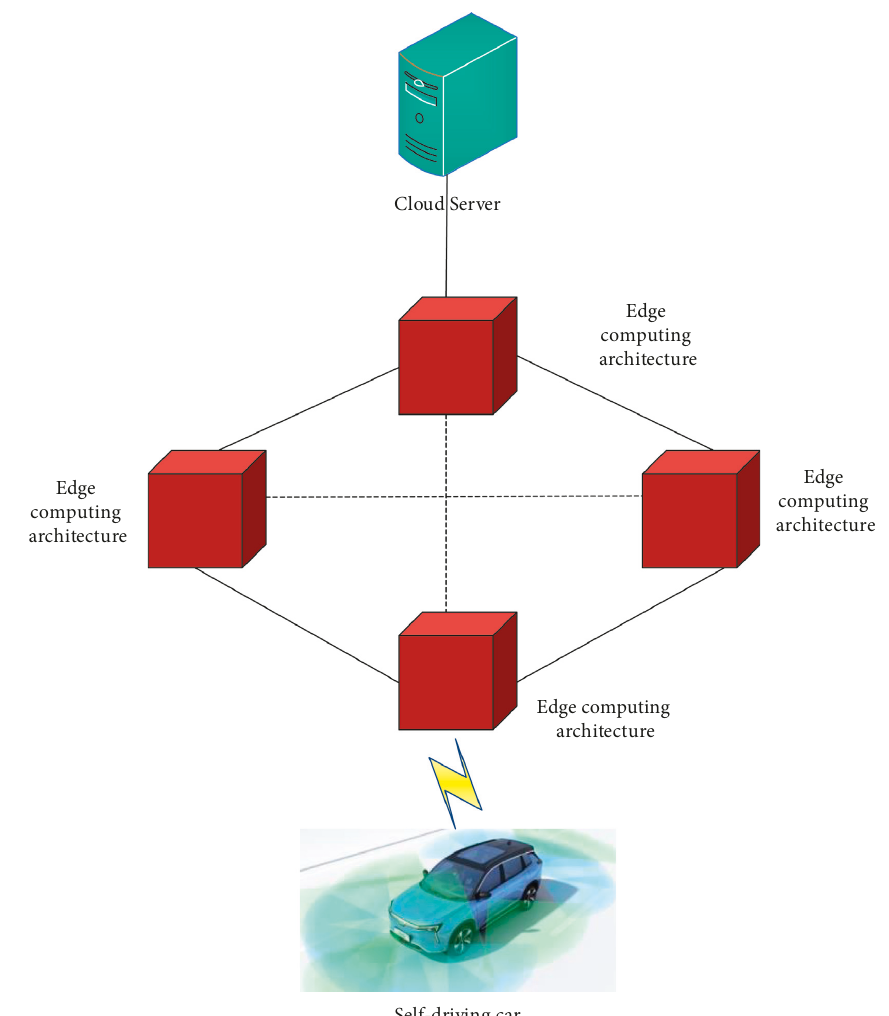
Figure 6: Edge computing in automotive